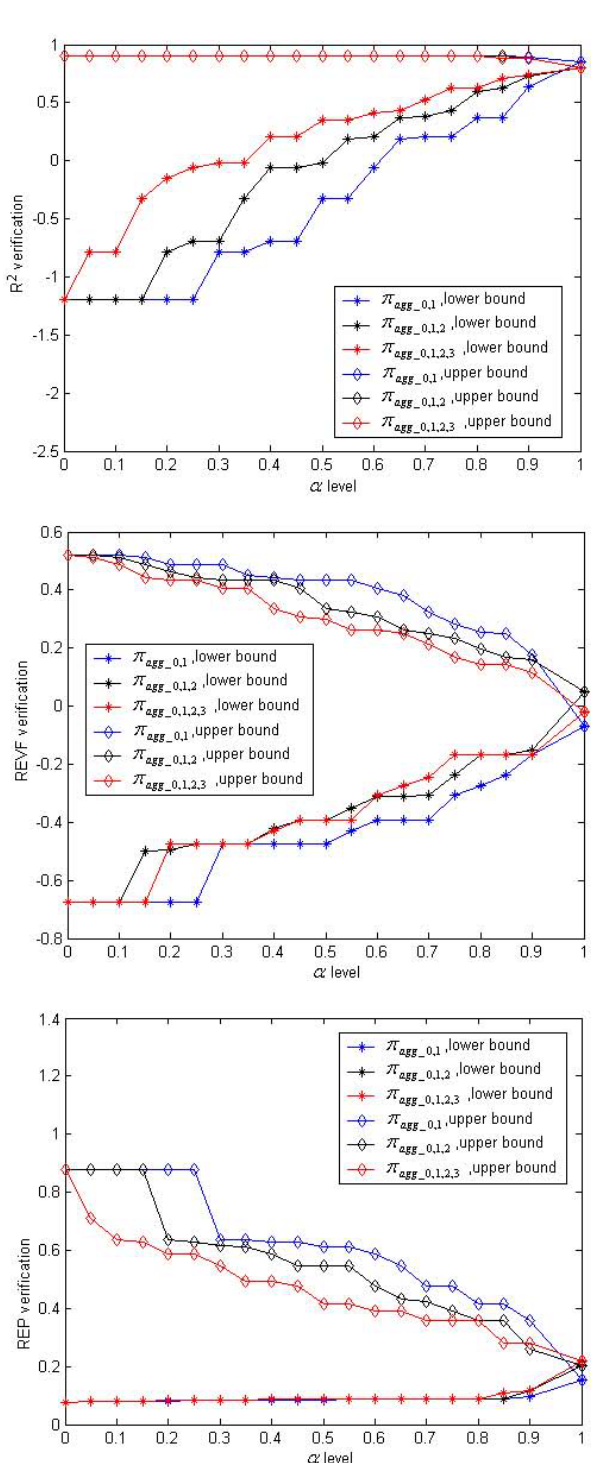
Fig. 5. Ranges of model performance statistics during the ver- ification period of the simulations retained above given possibil- ity levels α of the possibility distributions π agg 0 , 1 , π agg 0 , 1 , 2 and π agg 0 , 1 , 2 , 3